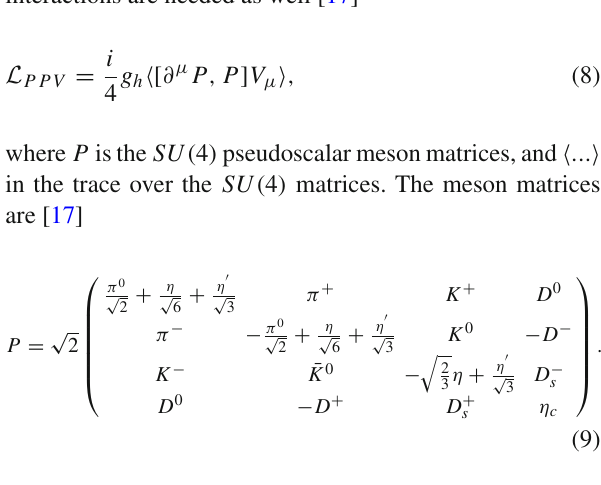
Fig. 2 Feynmandiagramsforthe (cid:2) ∗ c → (cid:3) + c K − , (cid:2) c π ,and (cid:4) c ¯ K decay